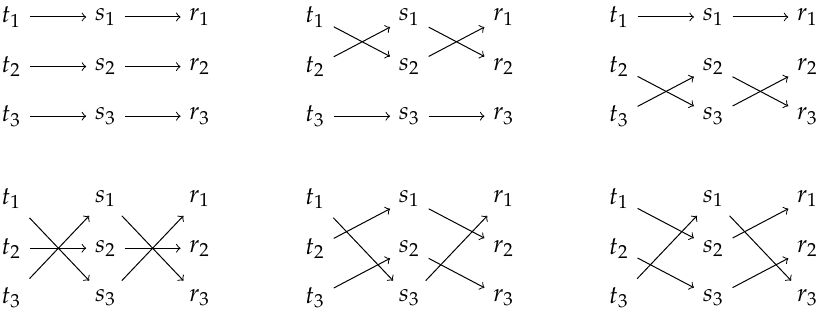
Figure 1. The six perfect signaling systems of the 3 × 3 Lewis signaling